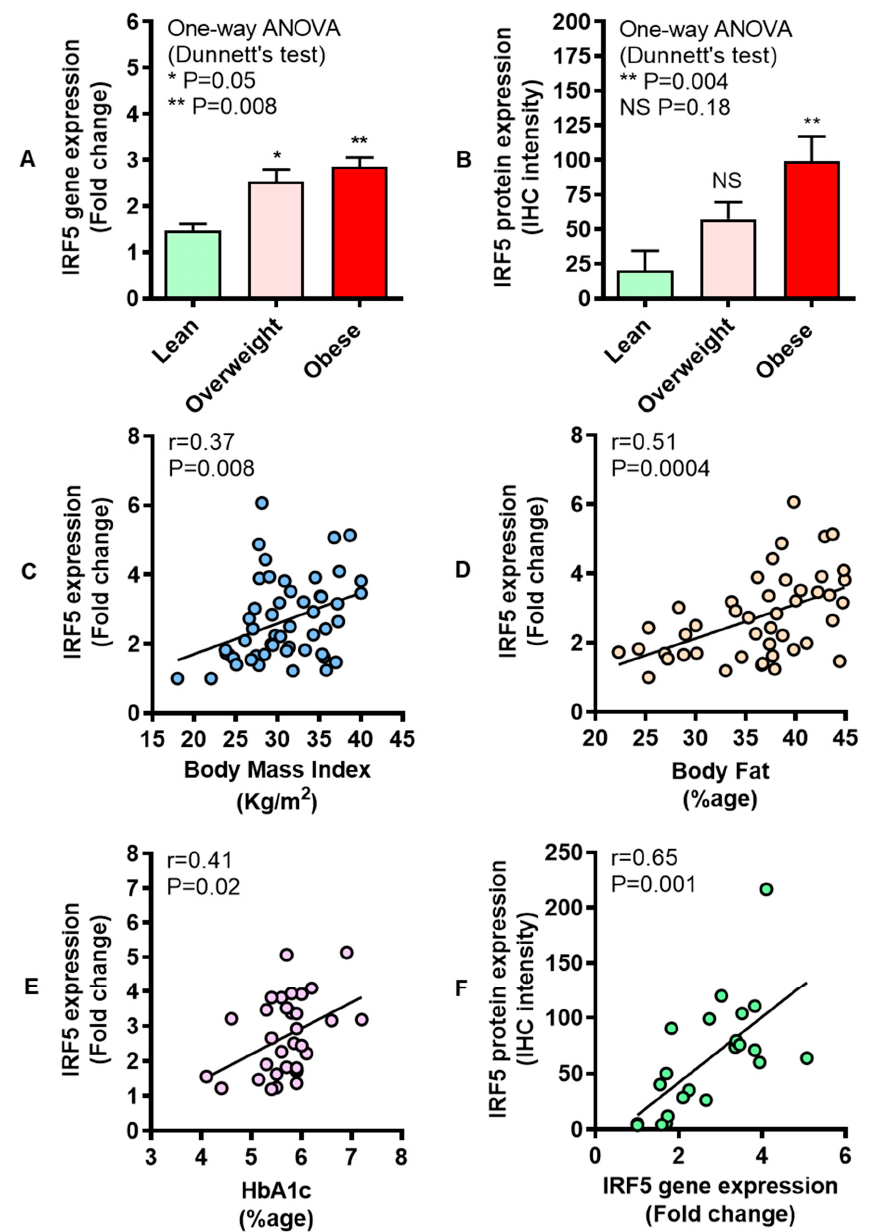
Figure 1. Enhanced adipose interferon regulatory factor-5 (IRF5) expression in obesity correlates with body mass index (BMI), body fat percentage, age, and levels of glycated hemoglobin (HbA1c). Adipose tissue IRF5 gene expression was determined in 53 non-diabetic individuals grouped as six lean, 18 overweight, and 29 obese using real-time RT-PCR. IRF5 protein expression was determined in six lean, eight overweight, and eight obese individuals using immunohistochemistry (IHC) as described in Materials and Methods. The data (mean ± SEM) show that ( A ) IRF5 adipose gene expression was elevated in overweight (P = 0.05) and obese (P = 0.008) compared with lean individuals. ( B ) As expected, IRF5 protein expression (arbitrary units) was also higher in obese (P = 0.004) compared with lean subjects; however, the di ff erence between overweight and lean individuals could not attain statistical significance (P = 0.18). Furthermore, IRF5 adipose gene expression associated positively with clinical markers including ( C ) BMI (r = 0.37, P = 0.008), ( D ) body fat percentage, age (r = 0.51, P = 0.0004), and ( E ) HbA1c (r = 0.41, P = 0.02). ( F ) Adipose IRF gene and protein expression was found to be mutually concordant (r = 0.65, P = 0.001). The asterisks * and ** represent significance levels of P ≤ 0.05 and P < 0.01,